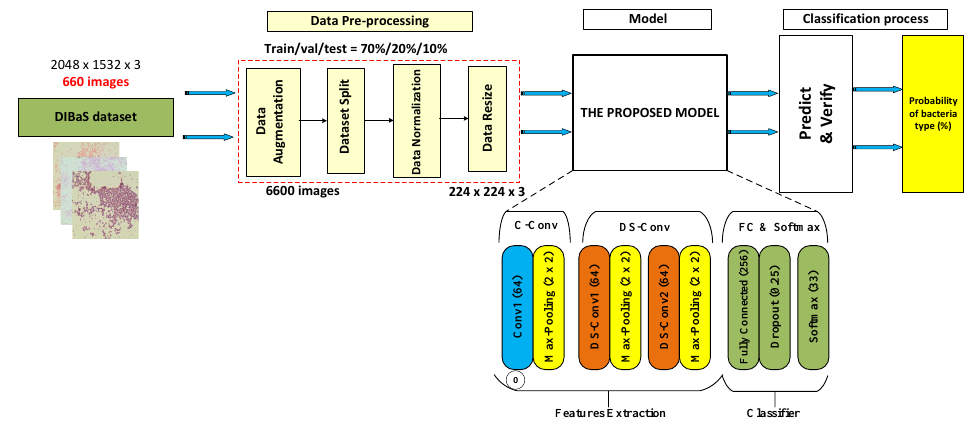
Figure 3. Schematic overview of the network architecture.